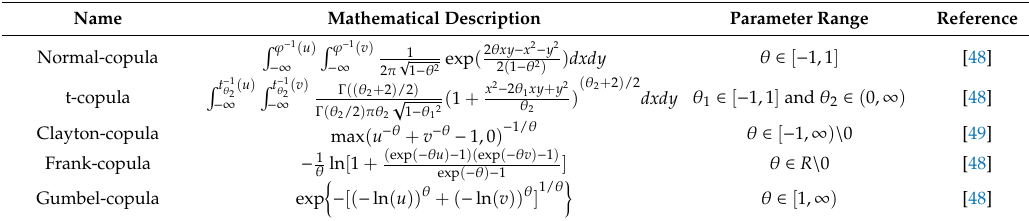
Table 2. Copula families used in this